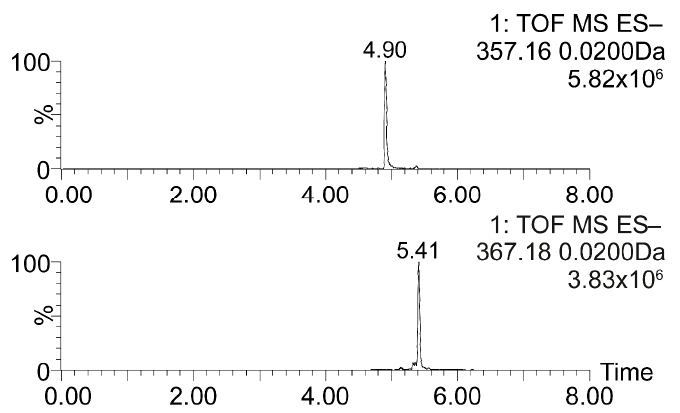
Figure 1 Figure 1. Extracted ion chromatograms (EICs) of m / z 357 (C 17 H 25 O 8- , top panel) and m / z 367 (C 19 H 27 O 7- , bottom panel) ions detected in laboratory-generated α -pinene/O 3 sample. The time axis is in